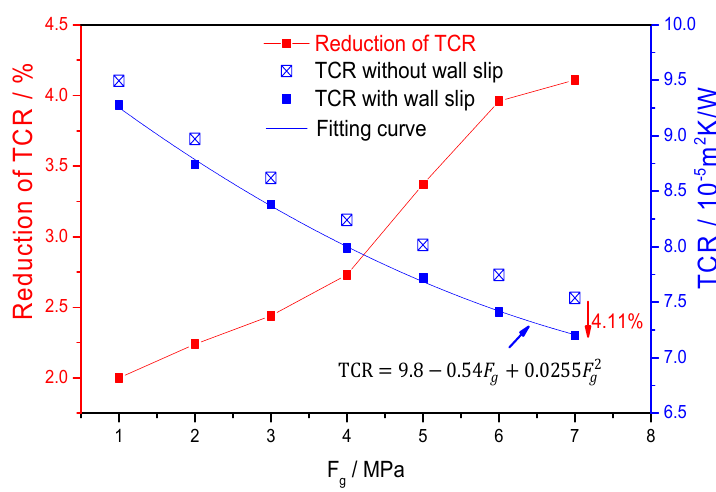
Figure 12. Thermal contact resistance (TCR) values under different external pressures.